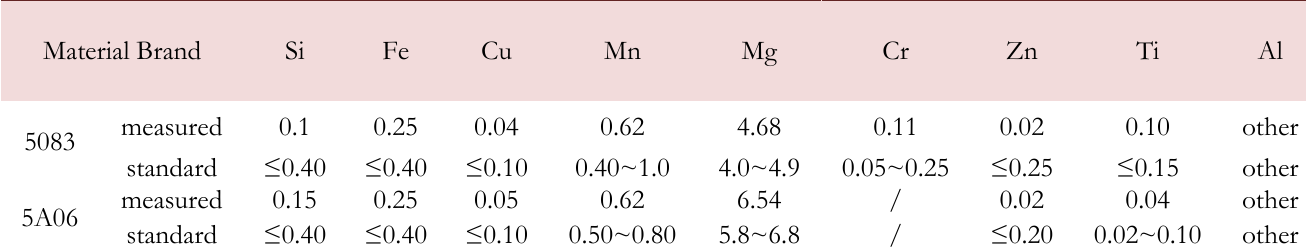
Table 2: Chemical composition of test materials (%).